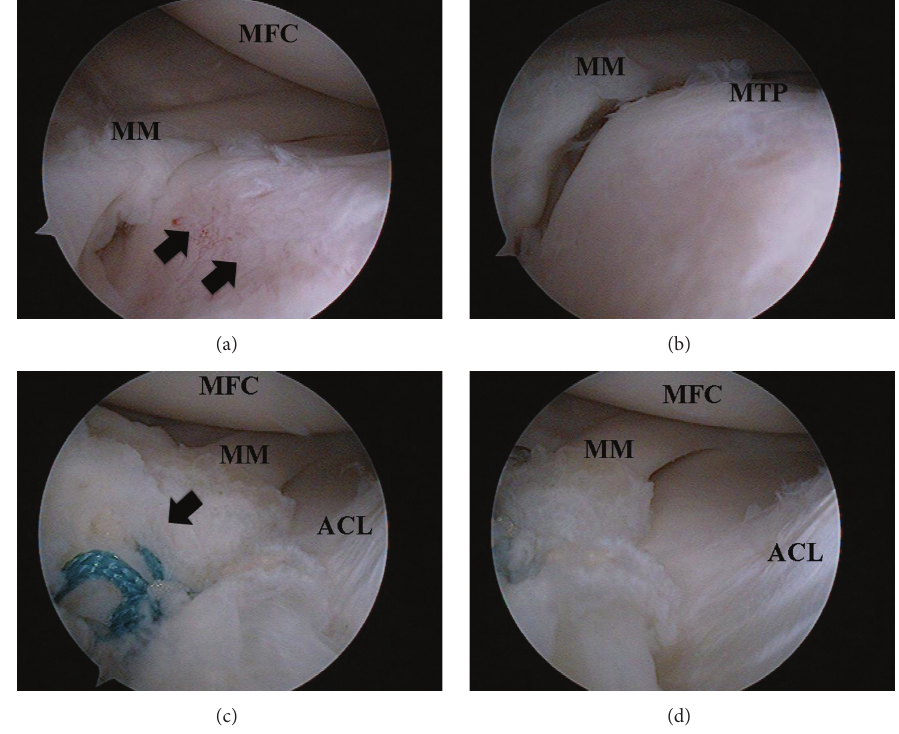
Figure 2: Arthroscopic views. (a) The anterior horn of the medial meniscus was detached and the anterior tibial surface was exposed (black arrow). (b) The anterior portion of the medial meniscus was subluxated with the knee flexed at 45 degrees. (c) The detached anterior horn was fixed to the tibial surface with a suture anchor (black arrow). (d) The anterior portion of the medial meniscus was not subluxated with the knee flexed at 45 degrees. MFC: medial femoral condyle, MM: medial meniscus, MTP: medial tibial plateau, and ACL: anterior cruciate